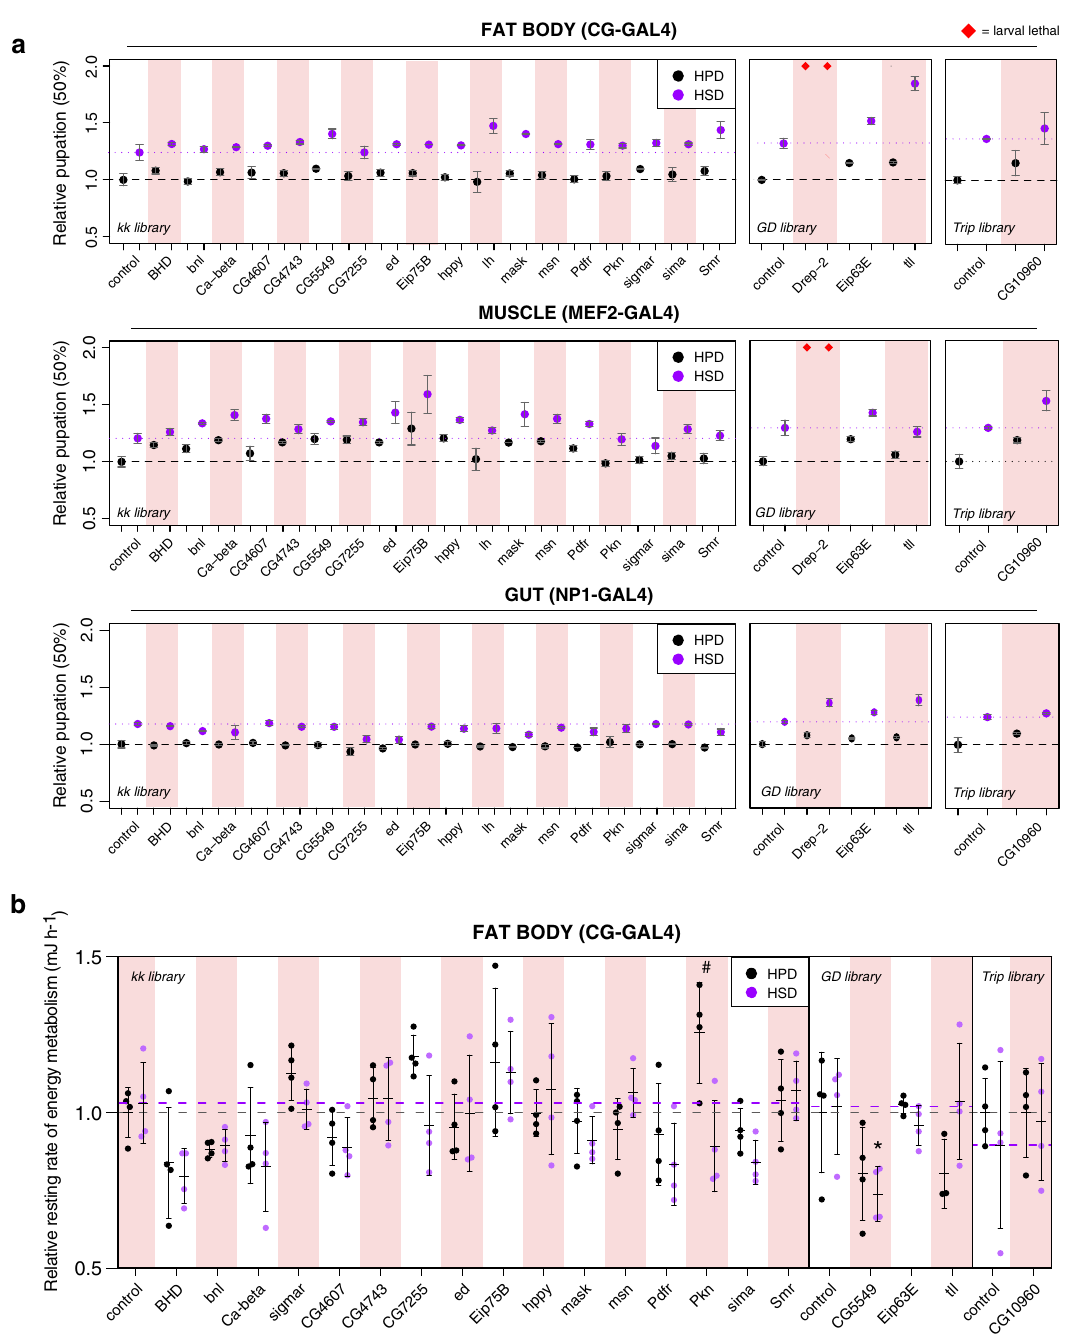
Fig. 4 Tissue-speci fi c metabolic phenotypes of the HSD hits. a The relative point (normalized to control) at which 50% of larvae pupated under tissue- speci fi c knockdowns ( Cg-GAL4 , Mef2-GAL4 and NP1-GAL4 ) of HSD hits. n = minimum of 3 vials (each with 30 larvae) per diet and genotype. Error bars display SD. See Source Data fi le for statistical analyses and exact p -values. b Relative resting rate of energy metabolism (mJ h − 1 ) of Cg-GAL4 knockdown of HSD hits (normalized to control HPD), n = minimum of 3 fl ies per diet and genotype. Error bars display SD. Statistical signi fi cances were calculated using the two-way ANOVA in conjunction with Dunnett ’ s multiple comparisons test (by genotype) and with Š ídák ’ s multiple comparisons test (by diet). Data are presented as mean values + / − SD. * p = 0.0348 (Dunnett ’ s multiple comparisons test), # p = 0.004 ( Š ídák ’ s multiple comparisons test). Source data are provided as a Source Data